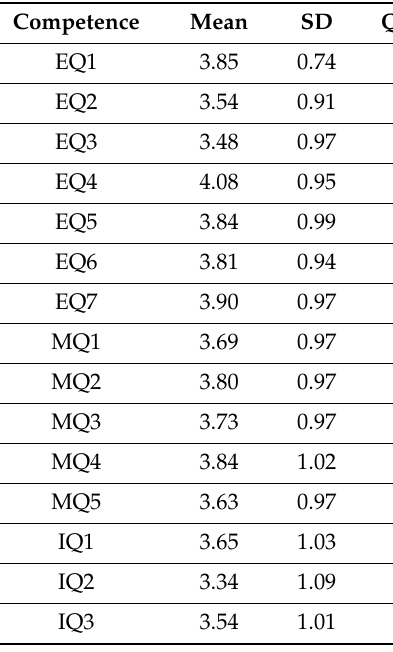
Table 3. The evaluation of the importance of competence of team